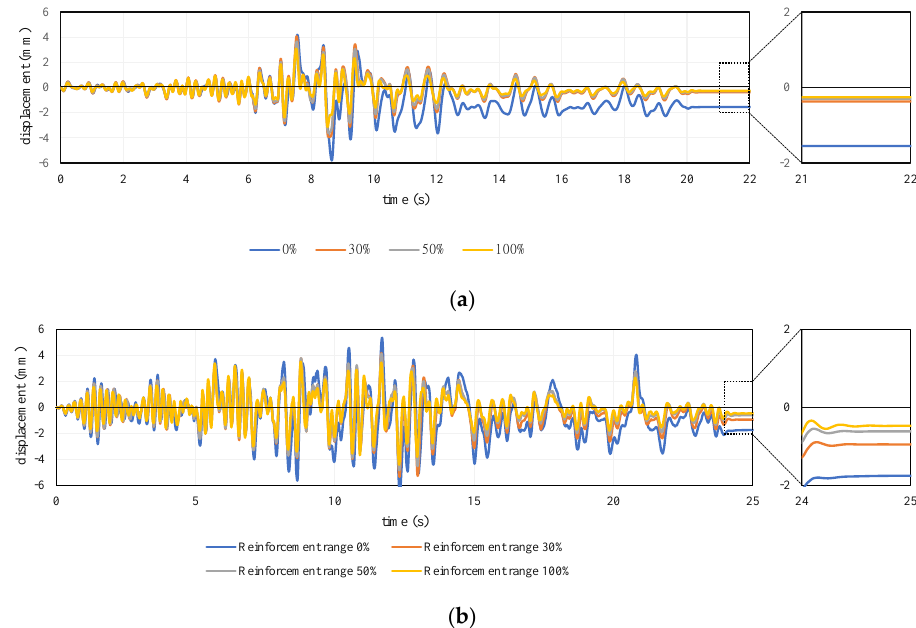
Figure 24. Comparison of displacement−time history at the top of the pier in TYPE-D: ( a ) under wave A; ( b ) under wave B.